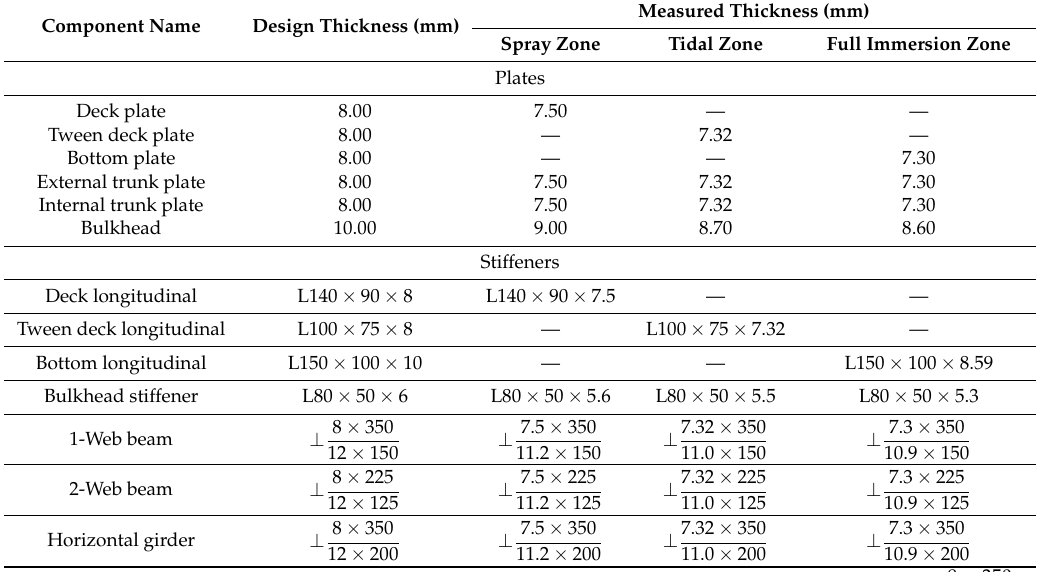
Table 4. Average measured residual thickness of typical plates and stiffeners in the protective device.